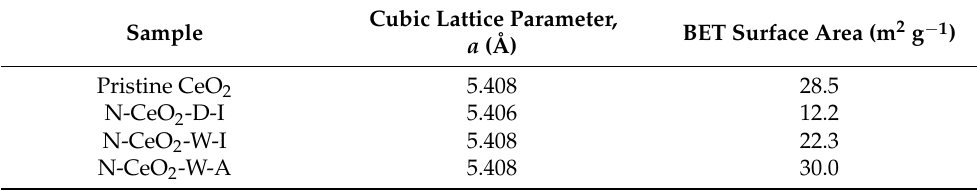
Figure 5. ( a ) Photographs of the pristine CeO 2 and the N-doped CeO 2 NPs. ( b ) XRD spectra of the pristine CeO 2 and the N-doped CeO 2 prepared by various methods.